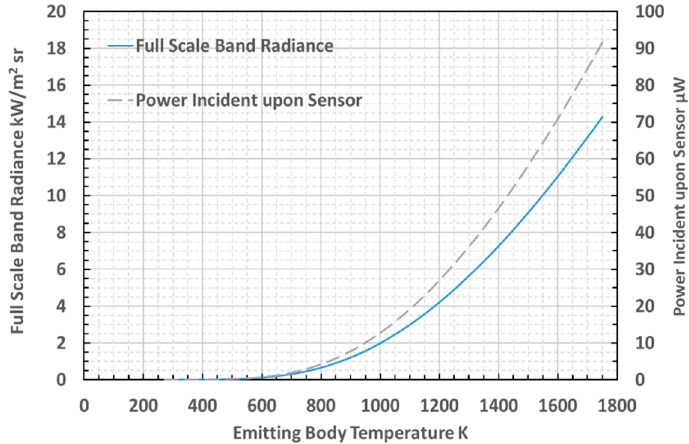
Figure 3. Calculated full scale band radiance and power incident upon InAsSb photodiode.